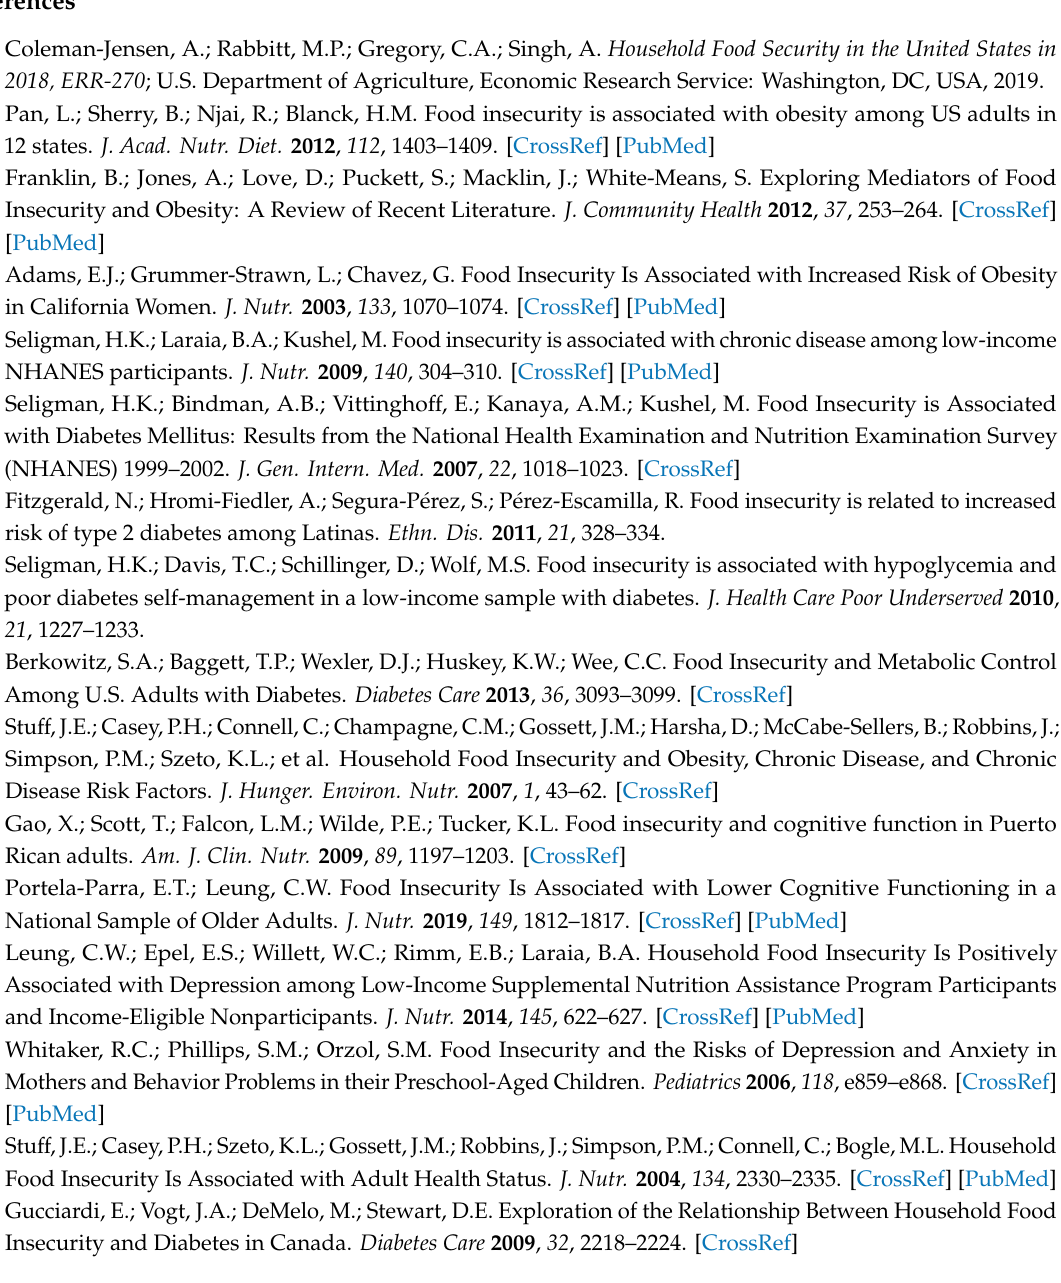
Table S1: Associations between household food security (using the four-category variable) and cumulative biological risk: National Health and Nutrition Examination Surveys